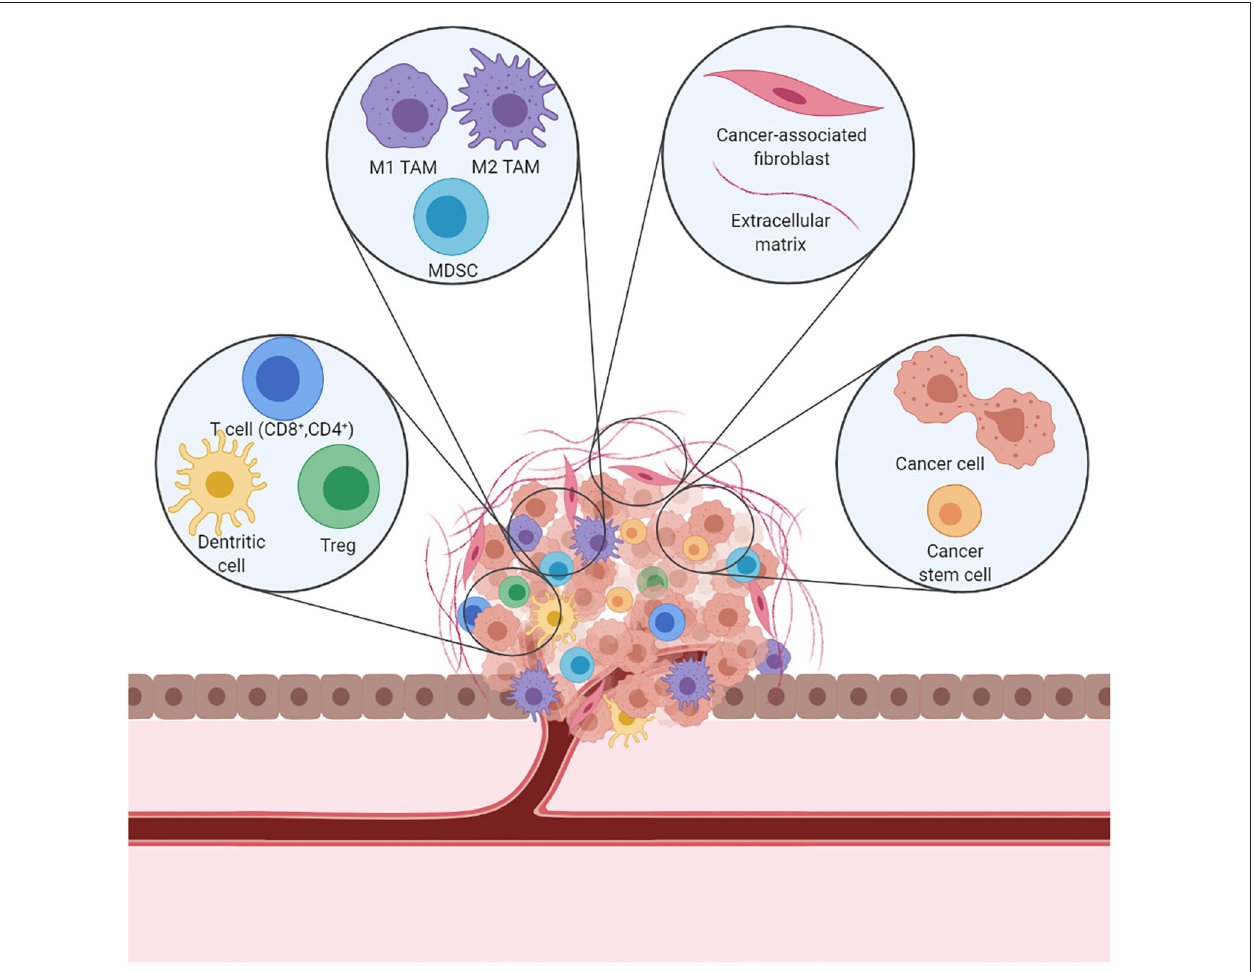
FIGURE 1 | A schematic representation of the immunosuppressive TME. In a tumor, cancer cells coexist with immune cells, fibroblasts, and blood vessels to form the TME. Cancer cells can alter the microenvironment and promote cancer growth and dissemination.